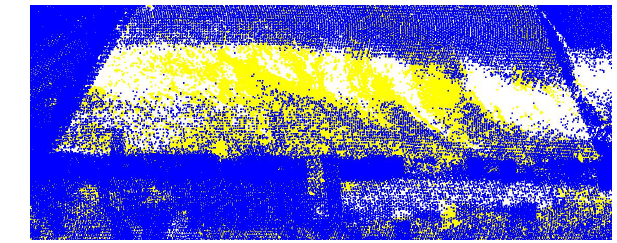
Figure 9: Number of sea bed points per depth level (Area 4).